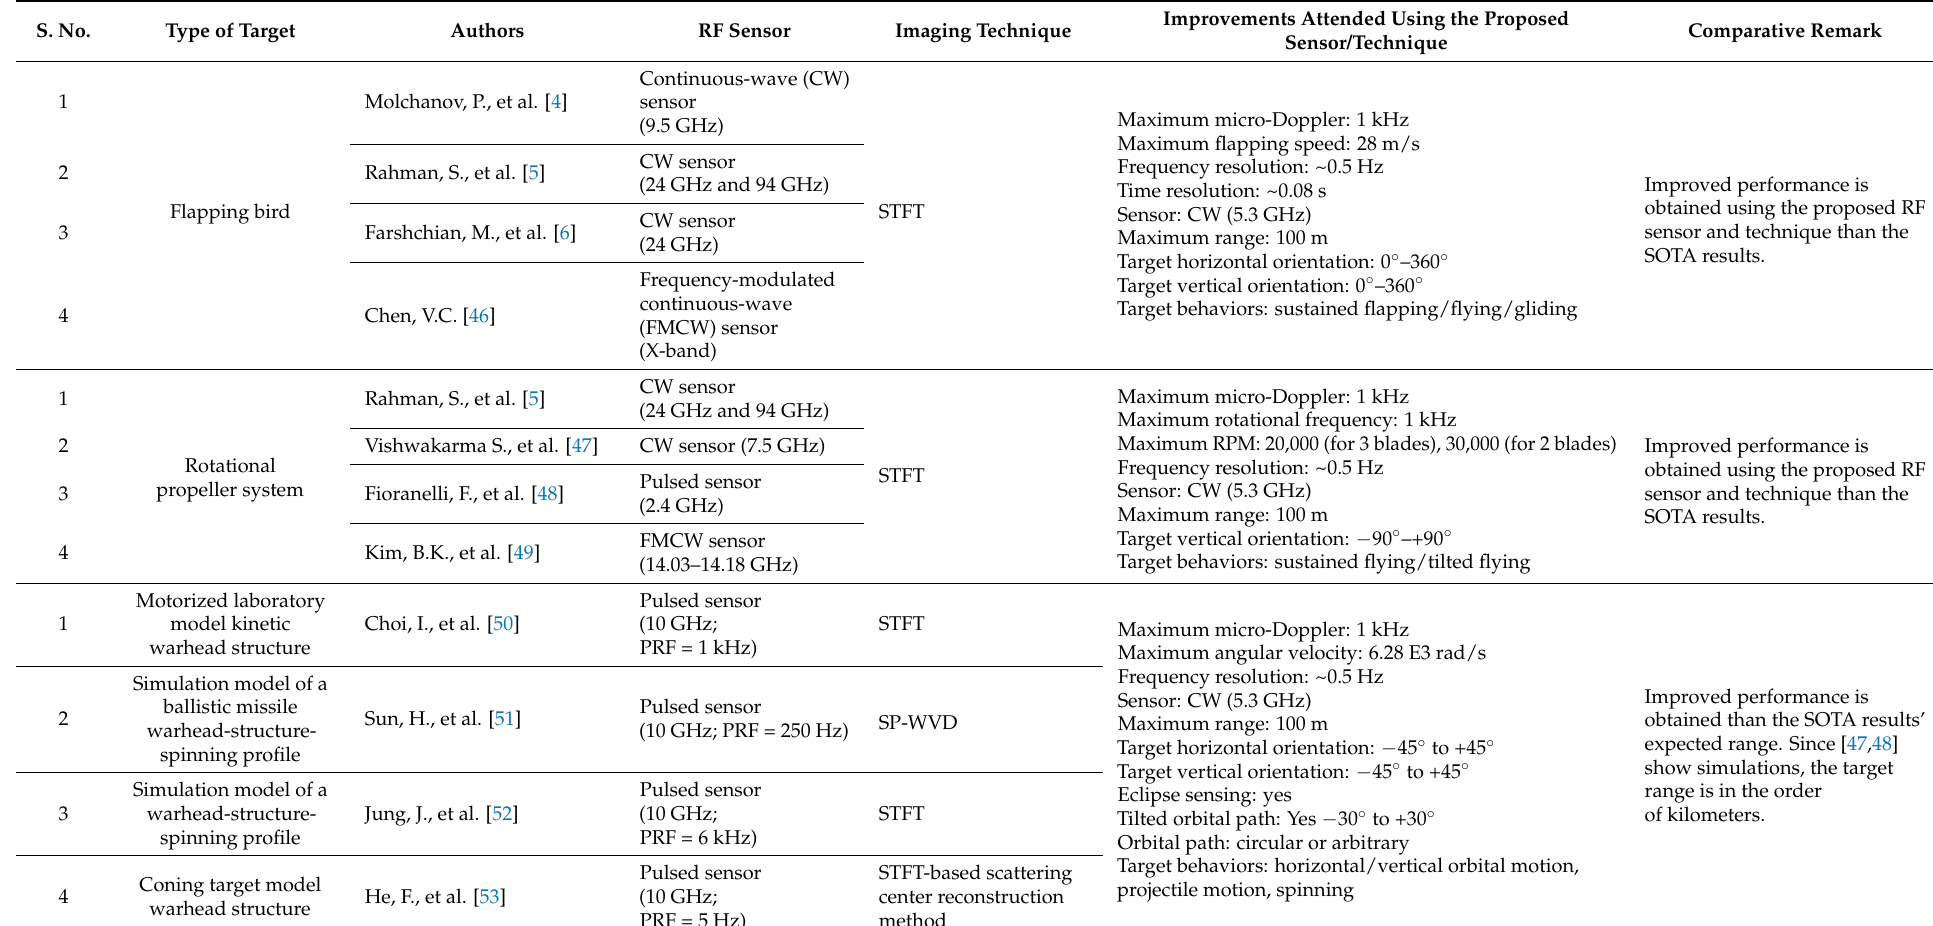
Table 2. State-of-the-art (SOTA) comparison of flapping, propeller rotation, and warhead-structure-motional micro-Doppler signature/pattern extraction/imaging